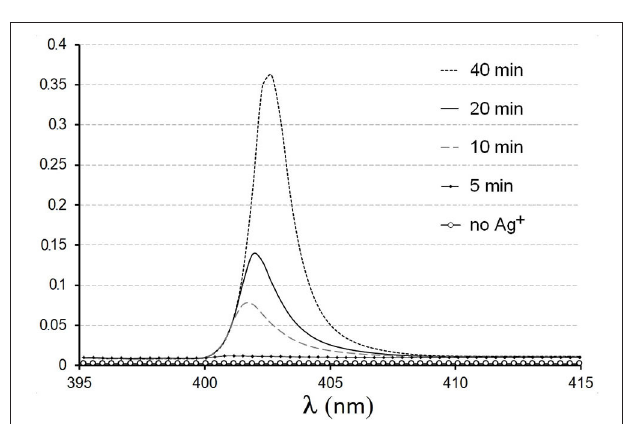
FIGURE 6 | Visible absorption spectra for different duration of biogenic Ag ◦ NPs generation.